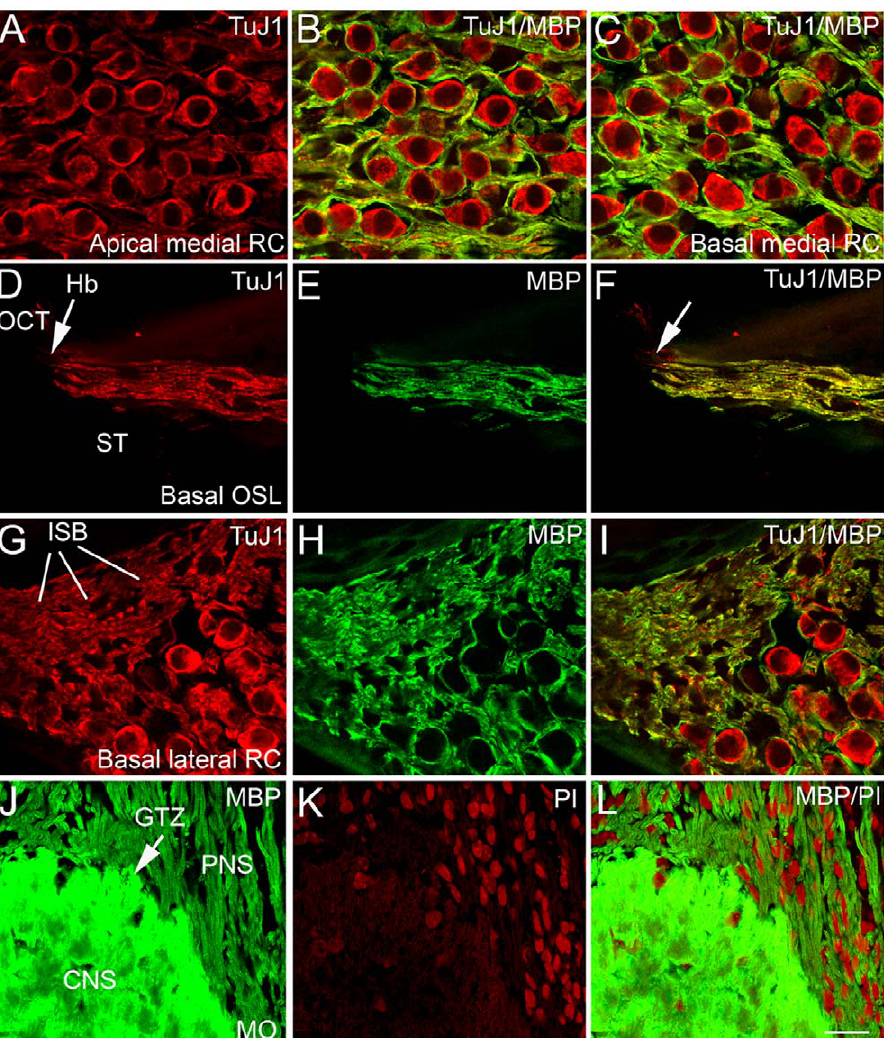
Figure 3. Immunohistochemical localization of myelin basic protein (MBP) in young adult CBA/CaJ mouse ears. A, B, C: Confocal images of SGNs labeled with anti-class III b -tubulin (TuJ1, red) and anti-MBP (green) within the medial portion of Rosenthal’s canal (RC) in the apical ( A,B ) and basal ( C ) turns of a one-month-old mouse. TuJ1 is a neuronal marker that preferentially labels the cytoplasm of type I SGNs and their processes. MBP labeling of myelin sheaths revealed a honeycomb-like staining pattern in the spiral ganglion. D, E, F: Myelinated peripheral processes in the osseous spiral lamina (OSL) of the basal turn of a three-month-old mouse stained strongly for MBP. A white arrow points to the habenula perforata (Hb) where auditory fibers lose their myelinated sheaths. G, H, I: MBP + fibers in the lateral portion of RC in the basal turn of a three-month- old mouse. MBP + myelinated fibers and MBP 2 unmyelinated fibers form intraganglionic spiral bundles. J,K,L: MBP + fibers in the glial transition zone (GTZ) of the modiolus (MO) ensheathed by oligodendrocytes (CNS) and Schwann cells (PNS). Nuclei were counterstained with PI (red). Organ of Corti, OCT; Scala tympani, ST. Scale bars, 12 m m in L (applies to A–L ).